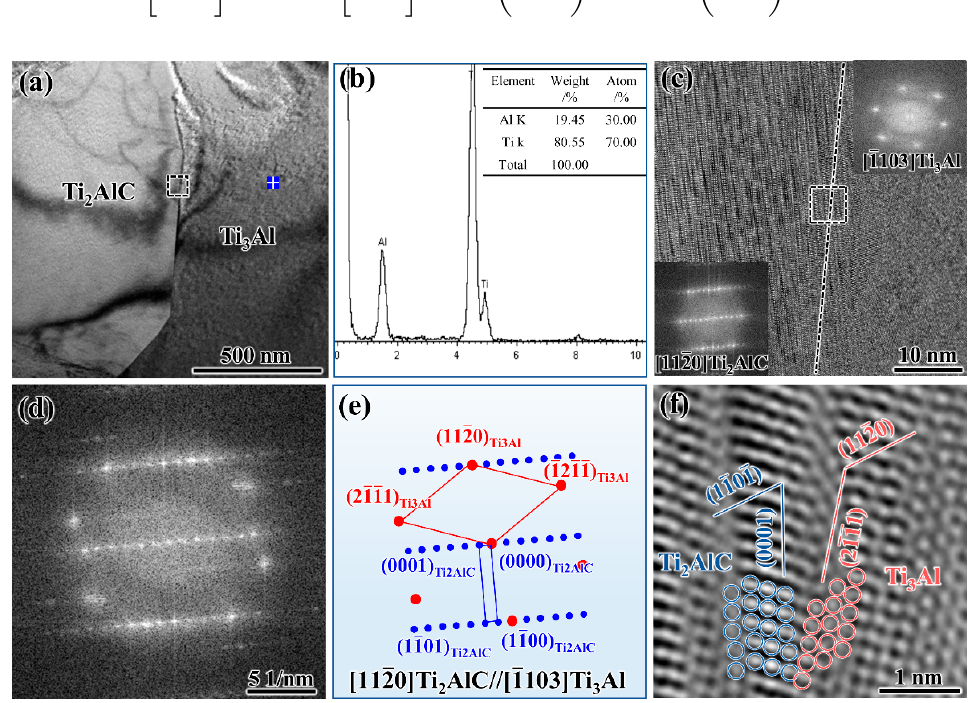
Figure 6. The TEM analysis of the Ti 2 AlC/Ti 3 Al interface: ( a ) TEM image; ( b ) EDS analysis of the area marked in ( a ); ( c ) HRTEM image of Ti 2 AlC/Ti 3 Al interface; ( d ) FFT pattern of Ti 2 AlC/Ti 3 Al interface; ( e ) Indexing of the FFT pattern in ( a ); ( f ) IFFT image of the square area in ( c ). The IFFT image of the Ti 2 AlC/Ti 3 Al interface in Figure 6c is demonstrated in Figure 6f. As indicated in the Figure 6f, the blue circles and red circles represent the Ti 2 AlC atoms and Ti 3 Al atoms, respectively. It can be observed that the Ti 2 AlC(0001) plane is not parallel to the Ti 3 Al(21 (cid:3364) 1 (cid:3364) 1) plane, which indicates that the interface between Ti 2 AlC and Ti 3 Al is an